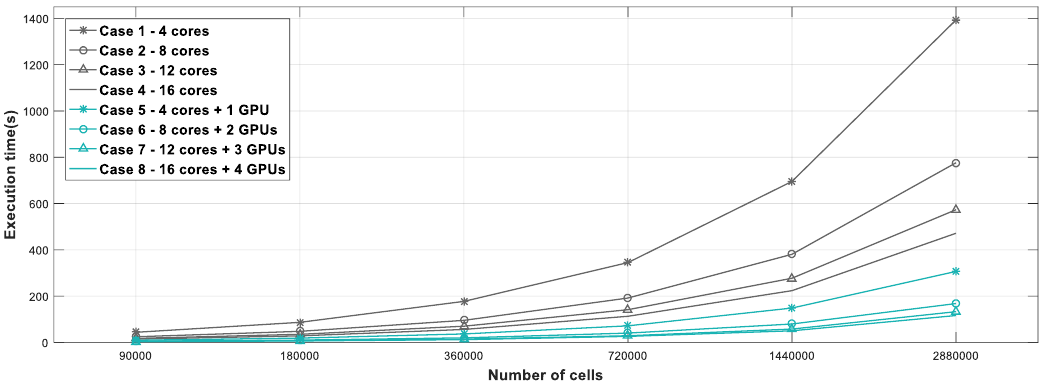
Figure 10. Execution time of simulation according to the number of cells.